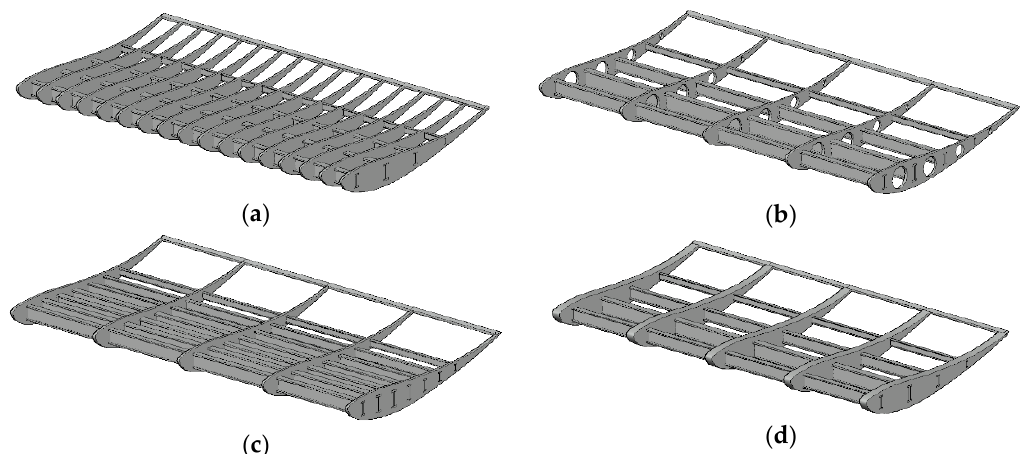
Figure 3. Examples of wing structural designs: ( a ) wing structure with high-density ribs; ( b ) ribs with implemented circular holes; ( c ) wing structure with high-density spars; ( d ) ribs with high thickness.